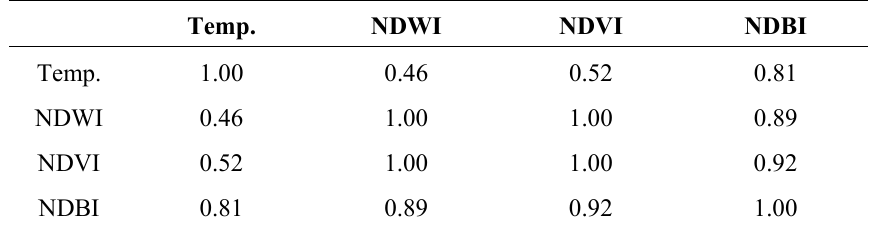
Table 5. Correlation matrix of the mean values from the indices and LST in an urban cover pattern. Temp.